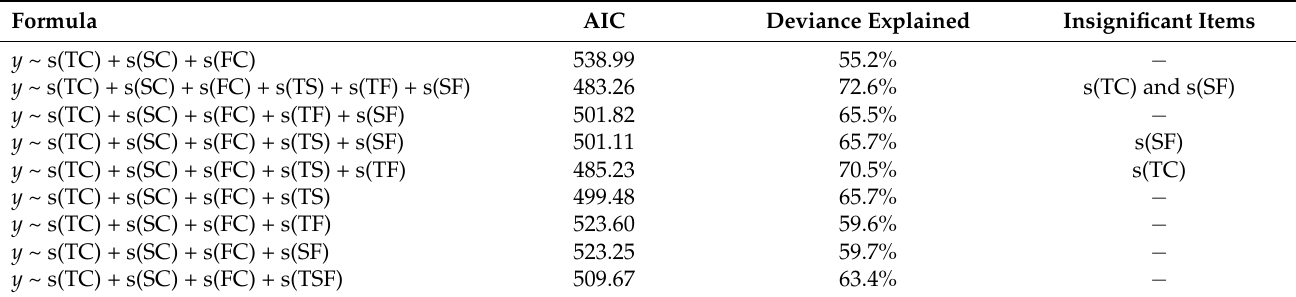
Figure 2. Partial residuals and smooth of each of the three plant coverage variables and the contribution rates to the deviance for the GAM fit. ( a ) Coverage of trees; ( b ) coverage of shrubs; ( c ) coverage of forbs; ( d ) the contribution rates of the three coverage to the deviance from the GAM fit based on the three landscape variables. In panels ( a − c ), the closed points represent the partial residuals; the solid curve represents the estimate of each 1-D smooth; and the gray area represents two standard errors above and below the estimate of the smooth. Partial residuals for a smooth term are the residuals that would be obtained by removing the term of interest from the model while leaving all other estimates fixed (i.e., the estimates for the term plus the residuals) [15]. Panel ( d ) shows the contribution rates of the three explanatory variables and the unexplained deviance by the GAM. Table 3. Comparison among different candidate generalized additive models.